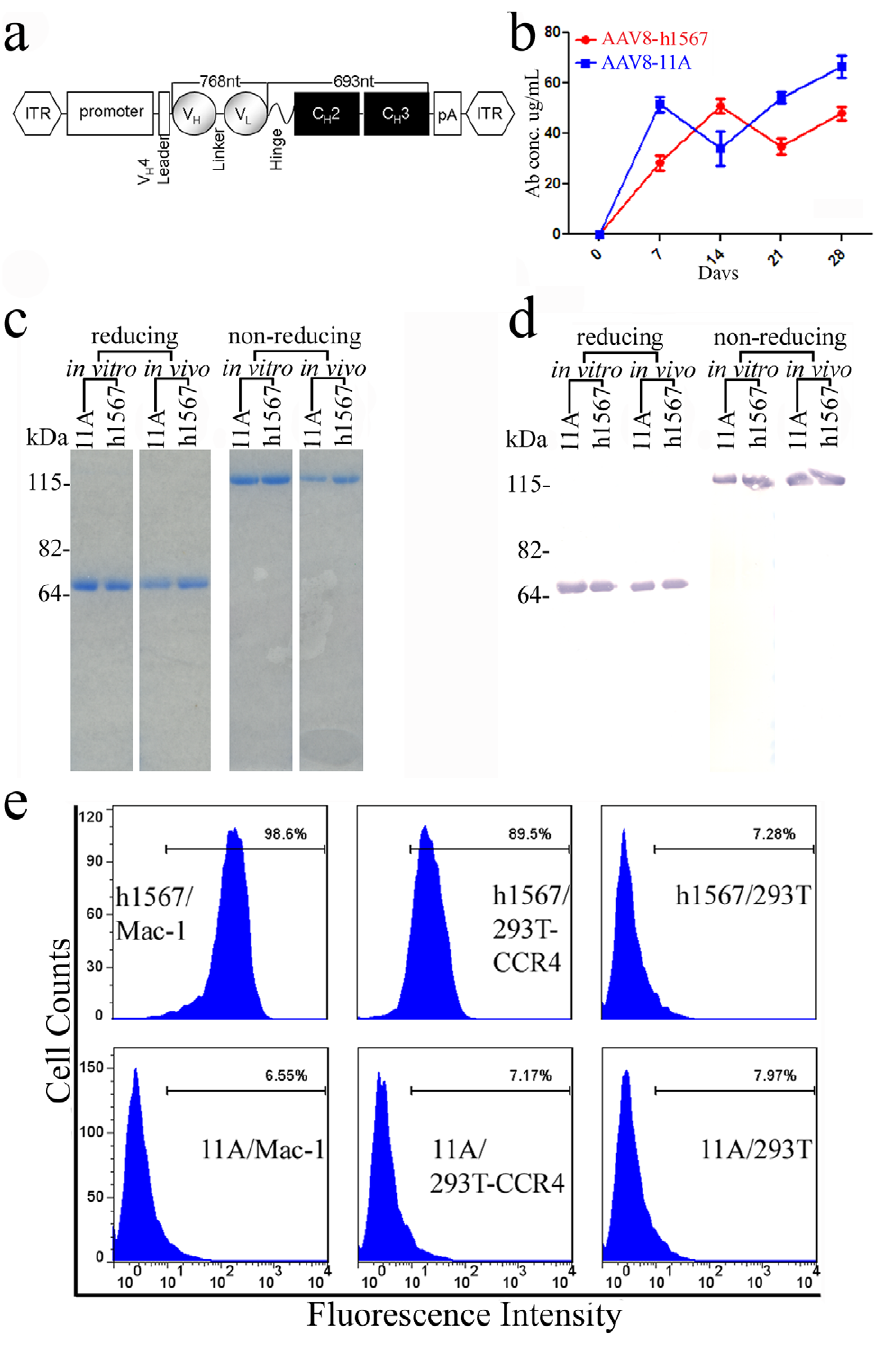
Figure 1. AAV vector construction and the expression of human mAbs in AAV-transduced mice. ( a ) Schematic representation of AAV- single chain variable region antibody (scFv) - human IgG1 Fc fusion (scFvFc) or ‘‘minibody’’ construct. Human mAb 11A (control) and ‘‘humanized’’ h1567 genes encoding the V domains of heavy (VH) and light (VL) chains were cloned between the AAV internal terminal repeats (ITRs) contained in vector pTRUF and expressed as a minibody protein. ( b ) In vivo transduction with AAV8-h1567-scFvFc and AAV8-11A-scFvFc in SCID-BEIGE mice after administering 2 6 10 11 vg (viral genome) units per mouse by a single intravenous (i.v.) tail vein injection and in a final volume of 150 ul PBS. Serum levels were measured over time by human IgG ELISA. ( c ) SDS-PAGE confirming the molecular weight and disulfide-bond integrity of the 11A and h1567 minibodies. ( d ) Western blotting analysis of the monomer and dimer forms of the 11A and h1567 minibodies using an anti-human IgG1-Fc antibody and processed under reducing and non-reducing conditions. (c & d) minibody proteins recovered from in vitro culture (left) and serum following in vivo transduction (right) are shown. ( e ) Binding specificity of the AAV8-derived h1567 minibody. The specific binding of h1567 scFv-Fc in serum was shown using CCR4-positive cell lines, Mac-1 and 293T-CCR4 by flow cytometry. An equivalent concentration of the control 11A minibody did not show any binding. 293T cells serve as CCR4 negative control cells.